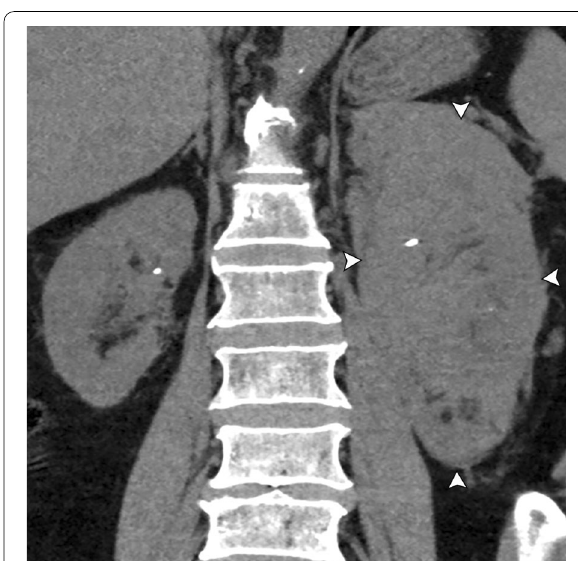
Fig. 6 Nephromegaly of renal lymphoma. Coronal noncontrast CT demonstrates infiltrative renal lymphoma with a diffusely enlarged left kidney replaced by tumor (arrowheads). Note the encasement and deformity of the pelvocalyceal system by tumor. This was pathologically confirmed as marginal zone